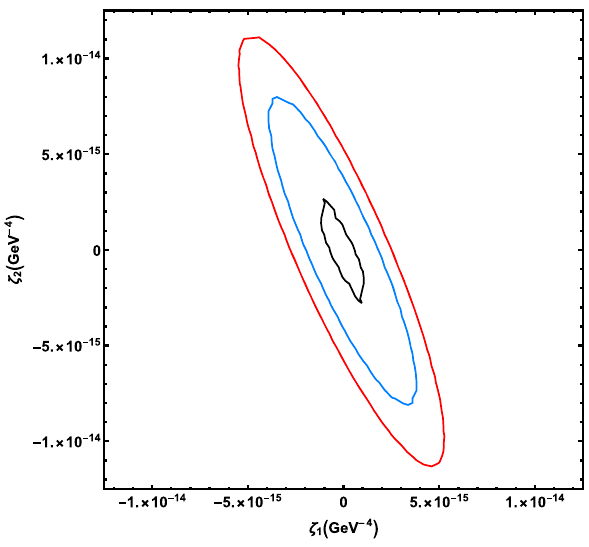
√ Fig. 7 The same as in Fig. 6, but for s = 3000 GeV and L = 5000 fb −